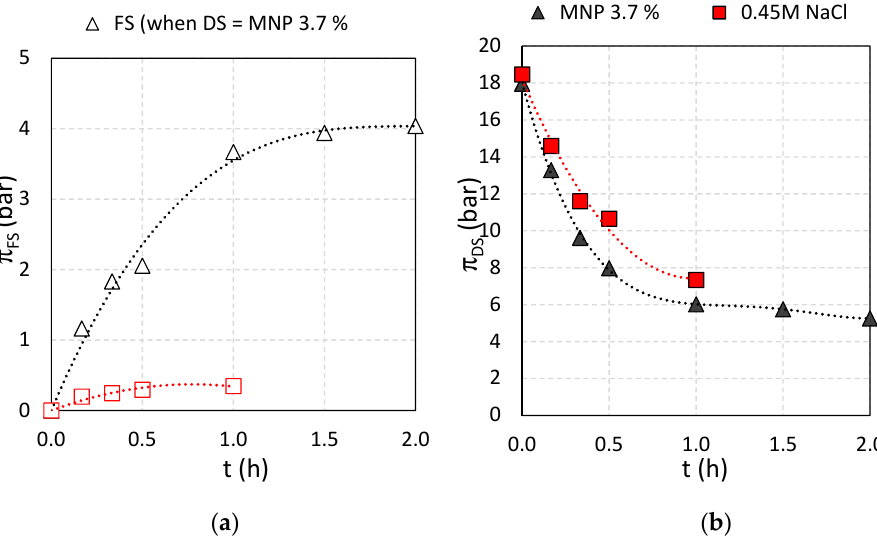
Figure 11. Osmotic pressures as function of time for ( a ) FS and ( b ) DS for 0.45 M NaCl and Fe 3 O 4 @CA as DS and DI water as FS, respectively.